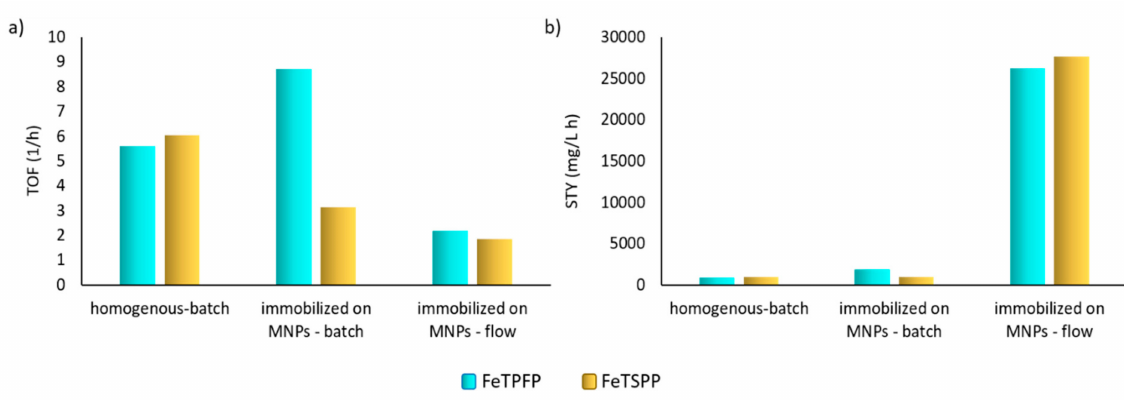
Figure 4. Turnover frequency (TOF) ( a ) and space time yield (STY) ( b ) values of metalloporphyrin (FeTPFPorFeTSPP)catalystsintheirsoluble(homogenous)orMNP-immobilized(heterogeneous)forms in biomimetic oxidation of amiodarone ( 1 ) in batch mode or continuous-flow magnetic chip reactor.